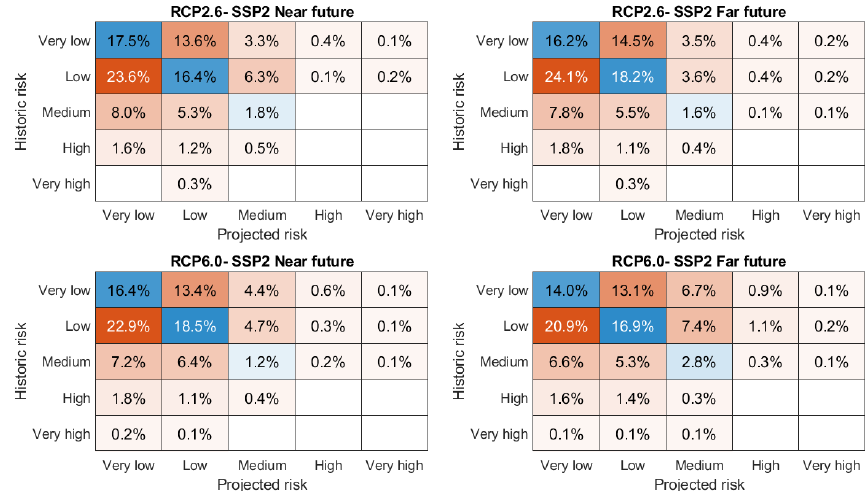
Figure 8. Transition of drought risk from baseline period to projected period. The value in each cell represents the change in percent area of the country from one risk class to another. The red colour shows transition, and blue represents no